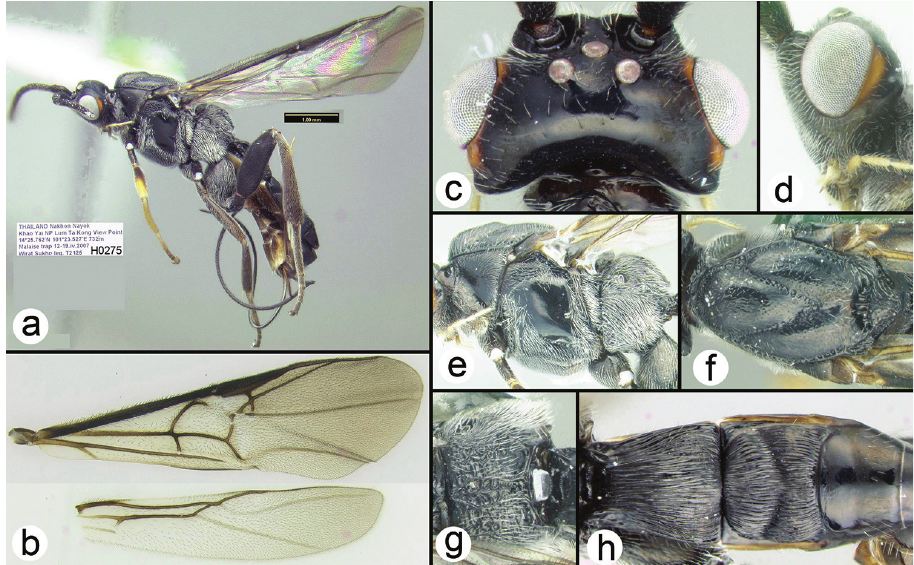
Figure 9. Gyragathis leucosoma, female holotype. a lateral habitus b wings c dorsal head d lateral head e lateral mesosoma f dorsal thorax g propodeum h metasomal terga 1-3. Leuroagathis Sharkey, gen.